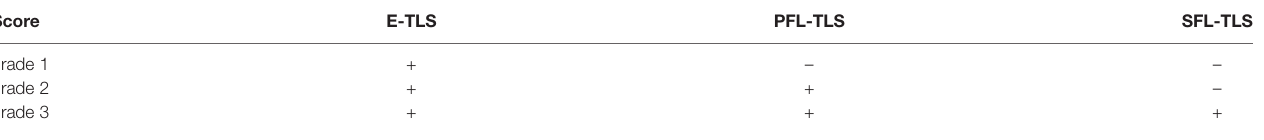
TABLE 2 | Patients score criteria in this study.